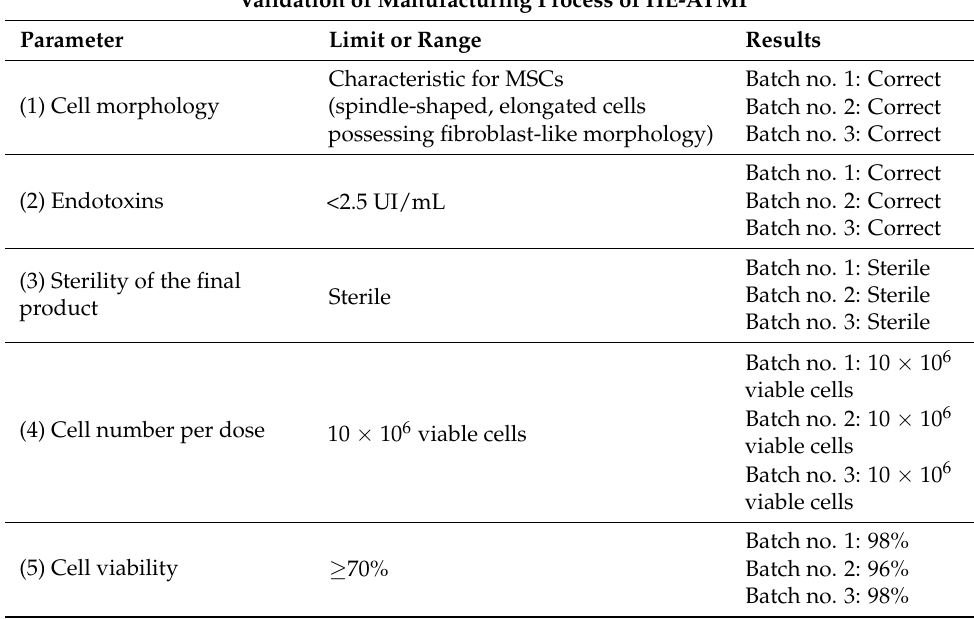
Table 3. Batch analysis for three validation series of